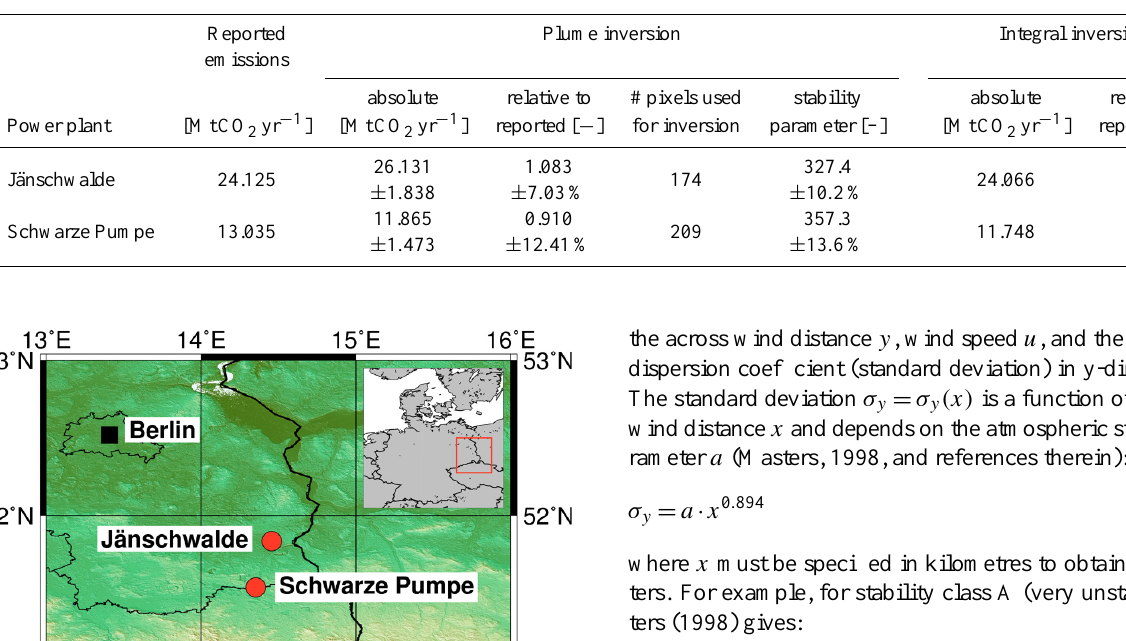
Table 10. Emission rate results for the power plants J¨anschwalde and Schwarze Pumpe using the Gaussian plume model and the Gaussian integral inversion methods. For the Gaussian plume model, the result for the retrieved stability parameter a and the statistical errors according to Eq. (21) are also given.